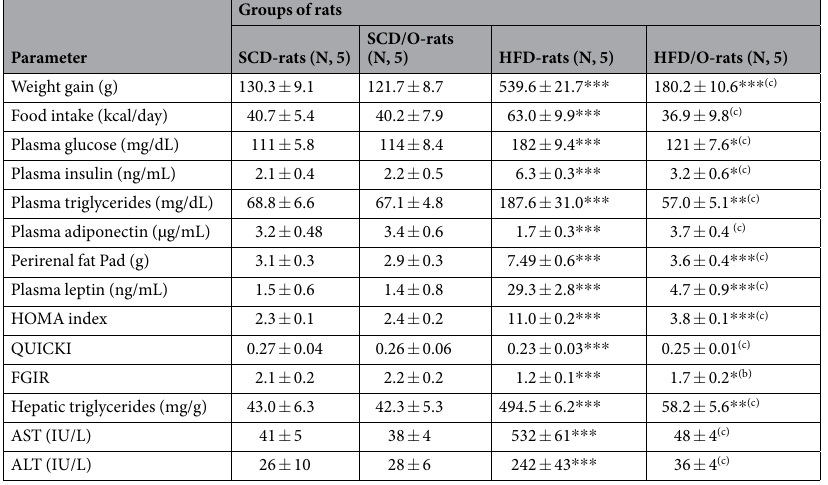
Table 1. Effects of omentectomy on metabolic syndrome in rats on a high fat diet (HFD). HOMA-IR, homeostasis model assessment of insulin resistance; QUICKI, quantitative insulin sensitivity check index; FGIR, fasting glucose-to-insulin ratio. Data are the mean ± S.D. Statistical differences were analyzed by two way